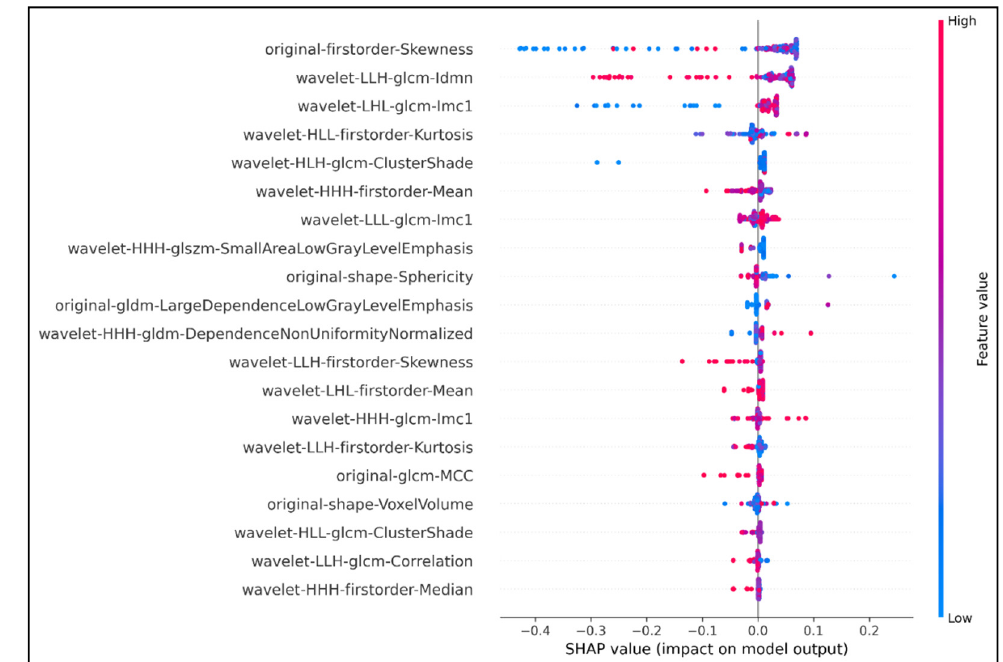
Figure 1. Top 20 features extracted using SHAP analysis. The horizontal axis showed how much the features contribute to the output predictor variable via SHAP values. Features were ranked based on their contribution to the output predictor; the higher the SHAP value, the higher the rank of the corresponding feature. The vertical axis with the color ranged from blue to red represented the value of a feature from low to high, respectively. The density of the colored dots in any SHAP value represented the strength or weakness of the feature in that SHAP value range. The original first order Skewness feature had the greatest impact on the predictability of the model. The SHAP value of original first order Skewness was 0.48 (absolute value of − 0.4 plus +0.08). The density of red and purple points concentrated in the range from 0 to +0.08 indicated that the predictive value of this feature was highest as its corresponding SHAP value was from 0 to +0.08. On the other hand, the feature wavelet HHH first order Median ranked last in the graph, with the lowest SHAP value 0.06 (absolute value − 0.05 plus +0.01), although it was still a relatively important feature (density thick red and purple dots).